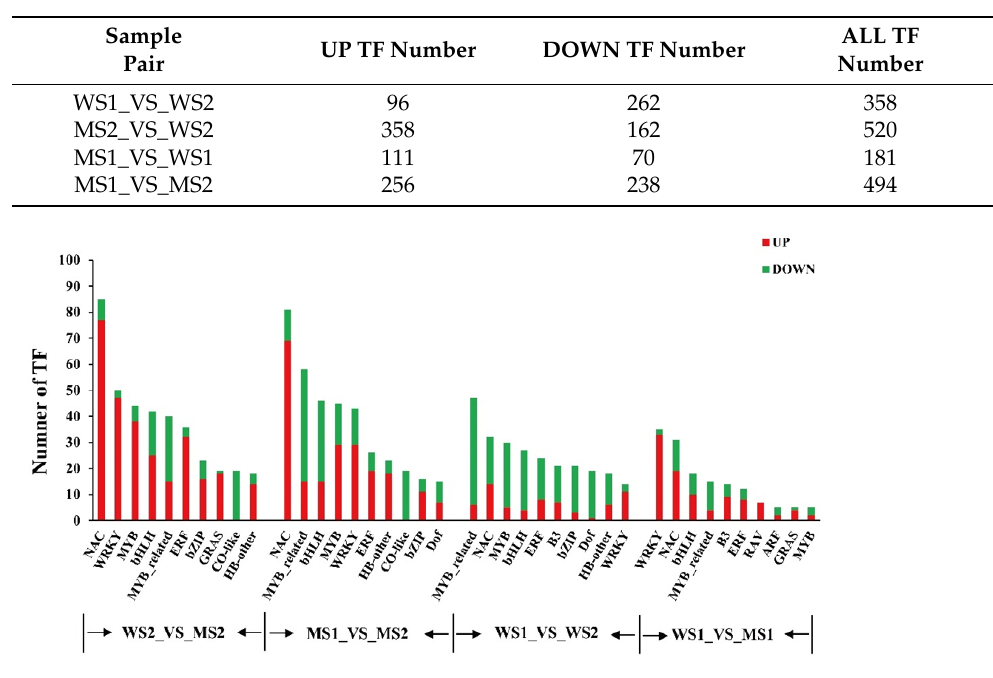
Table 6. Transcription factor statistics of 4 groups.